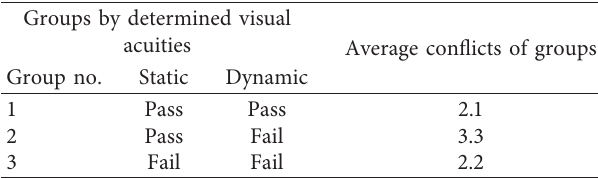
Table 5: Comparison of driving conflicts according to visual acuity performance. Groups by determined visual acuities Group